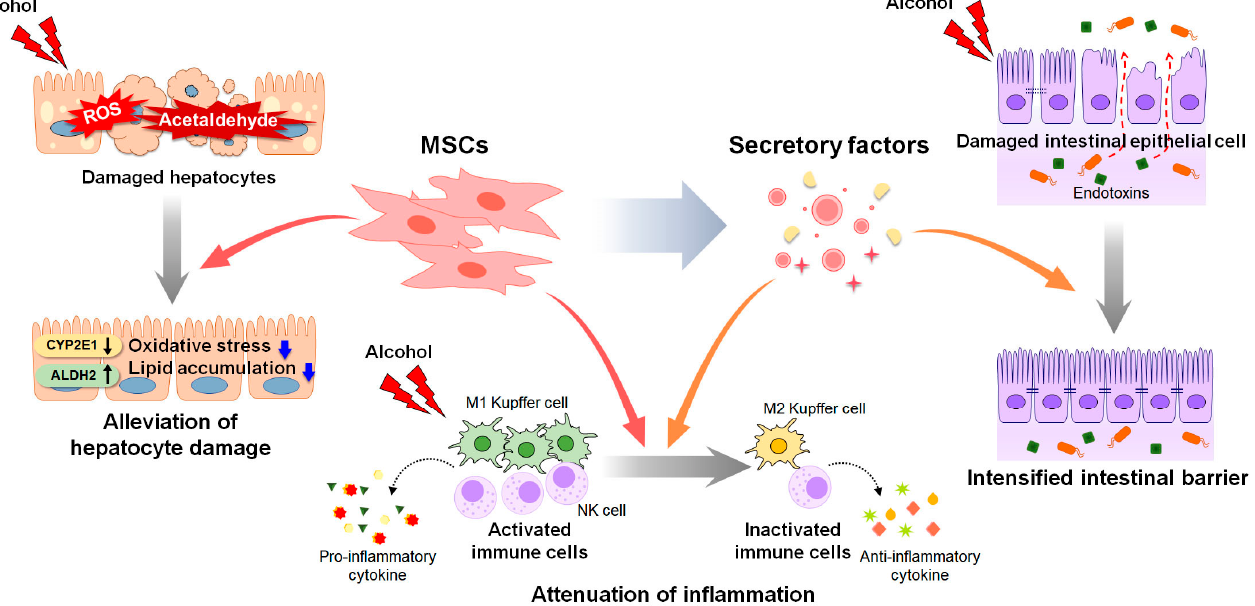
Figure 2. Therapeutic actions of MSCs and MSC-derived secretory factors in ALD. Mesenchymal stem cells (MSCs) and MSC-derived secretome have therapeutic potential for alcohol-induced liver damage. MSC transplantation decreases the expression of cytochrome P450 2E1 (CYP2E1) and in- creases the activity of the acetaldehyde-metabolizing enzyme aldehyde dehydrogenase 2 (ALDH2), reducing the levels of reactive oxygen species (ROS) and acetaldehyde induced by alcohol. Decreased ROS and acetaldehyde lower oxidative stress and lipid accumulation in hepatocytes. MSCs exert anti-inflammatory property by suppressing the activation of immune cells, including Kupffer cells and natural killer (NK) cells, and the secretion of pro-inflammatory cytokines. MSC-derived secretome such as cytokines, chemokines, free nucleic acids, and extracellular vesicles, alleviates hepatic inflammation by promoting polarization of Kupffer cells toward anti-inflammatory M2 phenotype. In addition, MSC-derived secretome directly improves viability of alcohol-damaged intestinal epithelial cells, and intensifies the intestinal barrier, blocking leakage of endotoxins from intes- tine.